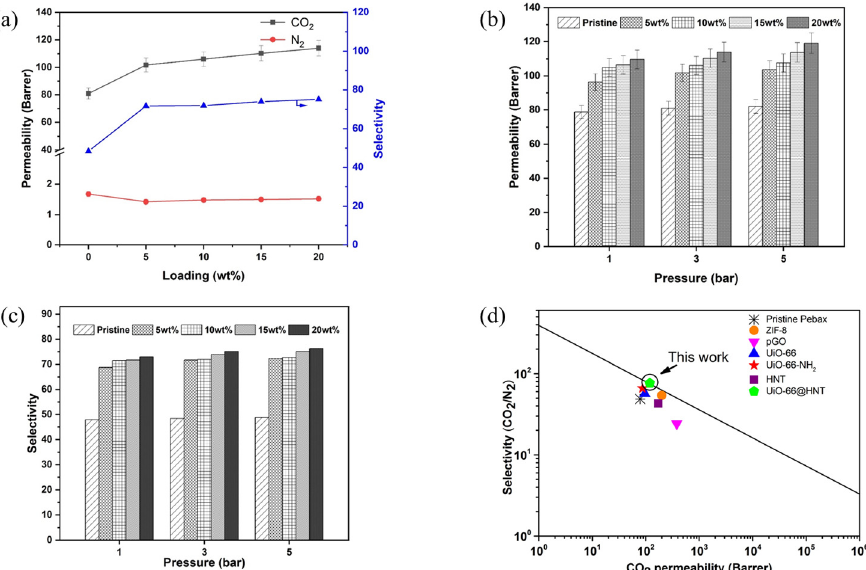
Figure 9. Gas permeation tests of UiO-66@HNT/Pebax MMMs: ( a ) CO 2 , N 2 permeability and CO 2 /N 2 selectivity of the membranes with different UiO-66@HNT loadings (0, 5 wt.%, 10 wt.%, 15 wt.%, and 20 wt.%); ( b ) CO 2 permeability in different pressure; ( c ) CO 2 /N 2 selectivity in different pressure; ( d ) the relationship between the CO 2 permeability and the CO 2 /N 2 selectivity of the MMMs prepared in this work and in the literature. Table 3. Comparison of the separation performance of other MMMs based on Pebax substrates in the literature with our current work under dry conditions.